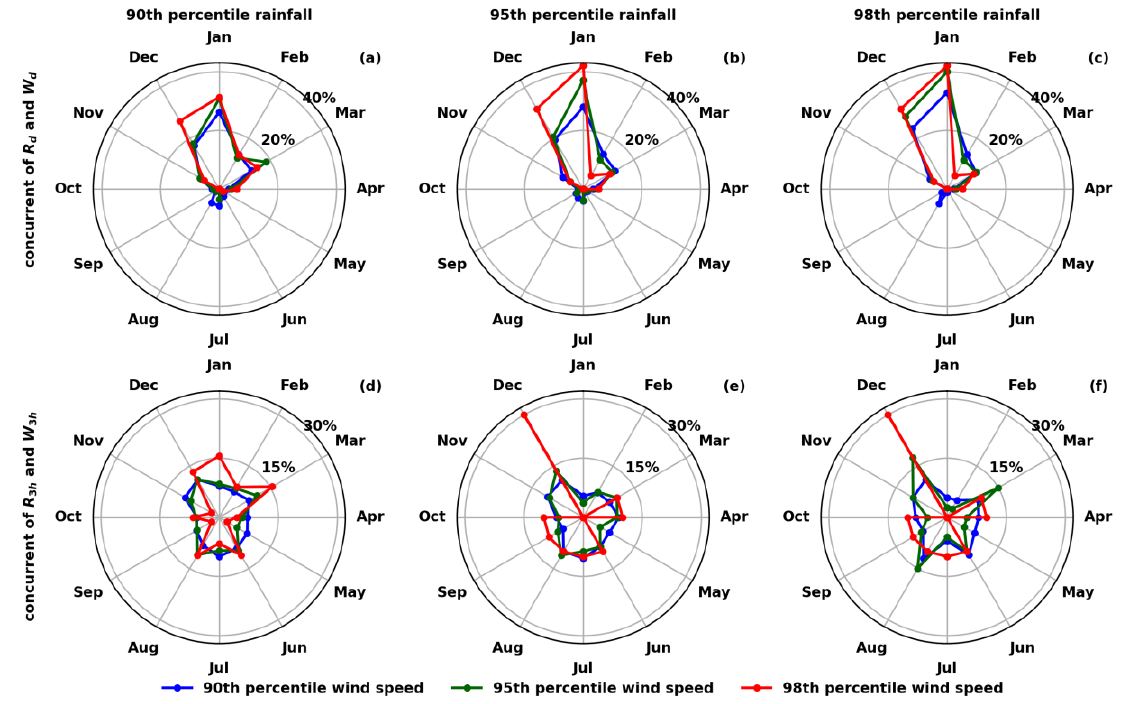
Figure 5. Intra-annual variability (number of events in the month relative to the total) of concurrent daily ( a – c ) and 3-hour ( d – f ) rainfall and wind speed extremes under different combinations of per- daily ( a – c ) and 3-h ( d – f ) rainfall and wind speed extremes under different combinations of percentile- centile-based thresholds. based